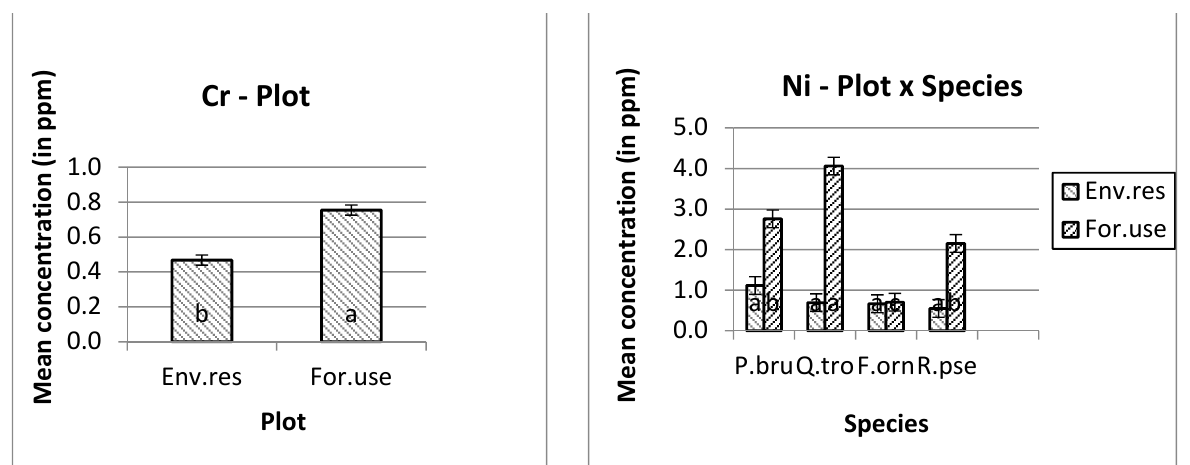
Figure 1. Mean and s.e. of the studied heavy metals concentrations. The differences in the mean values of the heavy metal concentration with different letters are significantly (ANOVA, p ˂ 0.05 and the Bonferroni Test of multiple comparisons.